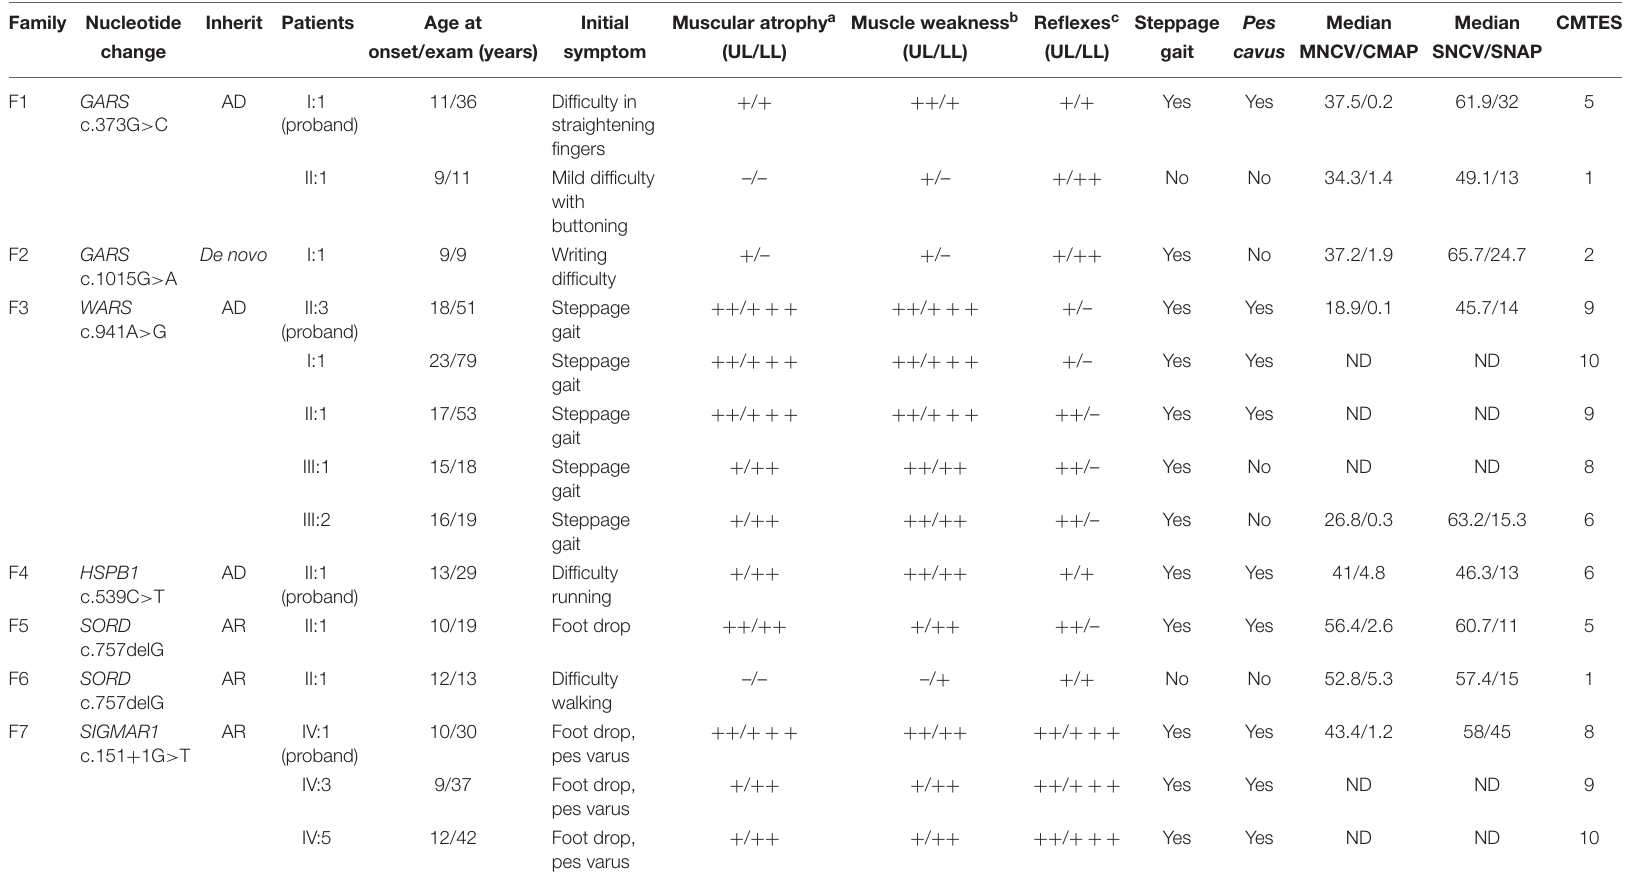
AD, autosomal dominant; AR, autosomal recessive; UL, upper limbs; LL: lower limbs; MNCV, motor nerve conduction velocity (in m/s); CMAP, compound muscle action potential (in mV); SNCV, sensory nerve conduction velocity (in m/s); SNAP, sensory nerve action potential (in uV); CMTES: Charcot-Marie-Tooth disease examination score; ND: not done. a Patients with muscular atrophy; –, normal; + , mild; ++ , moderate; + + + , severe (involved in proximal muscle). b Patients with muscle weakness: –, normal; + , ≥ 4 in distal muscles on MRC (Medical Research Council) scale; ++ , < 4 in distal muscles on MRC scale; + + + , proximal weakness (knee flexion and extension, elbow flexion and extension or above). c Tendon reflexes: –, loss; + , reduced; ++ , normal; +++ ,